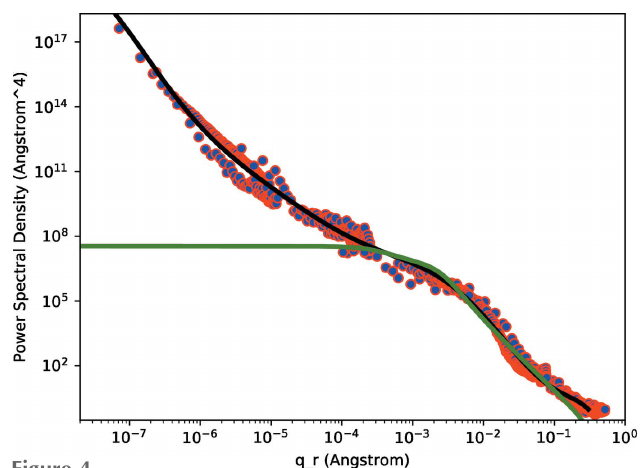
Figure 4 Power spectral density of the smooth sample. The data points were obtained from optical interferometry and from atomic force microscopy. The solid black curve is a polynomial fit to the concatenated data set. The solid green curve results from equation (8) applied to the correlation function shown in Fig. 6.